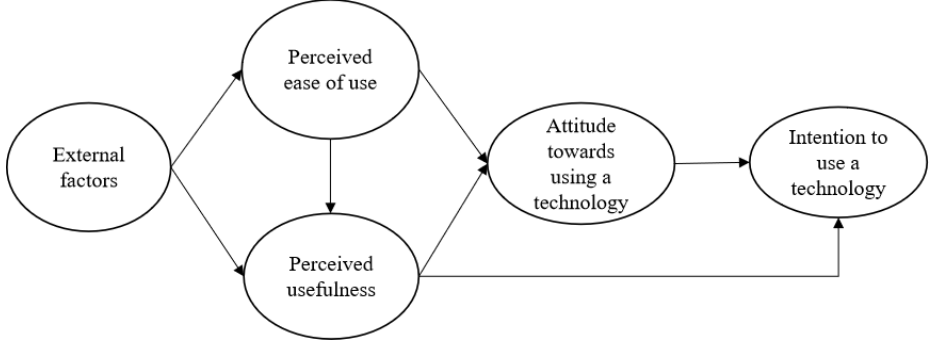
Figure 1. Technology acceptance theory proposed by Davis, Bagozzi and Warshaw